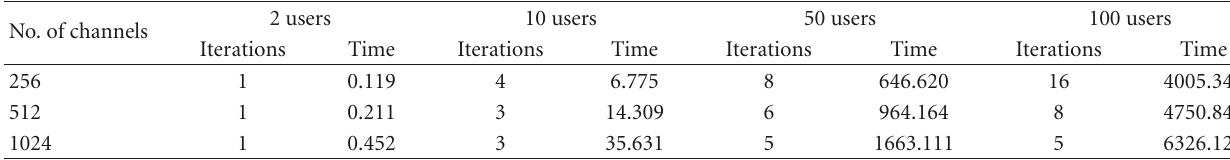
Table 7: Number of iterations and CPU time (seconds) required to achieve the budget allocation where the competitive equilibrium has balanced individual utilities in large-scale problems by the iterative method, di ff erence tolerance = 0.05 and average of 10 simulation runs. 2 users No. of channels